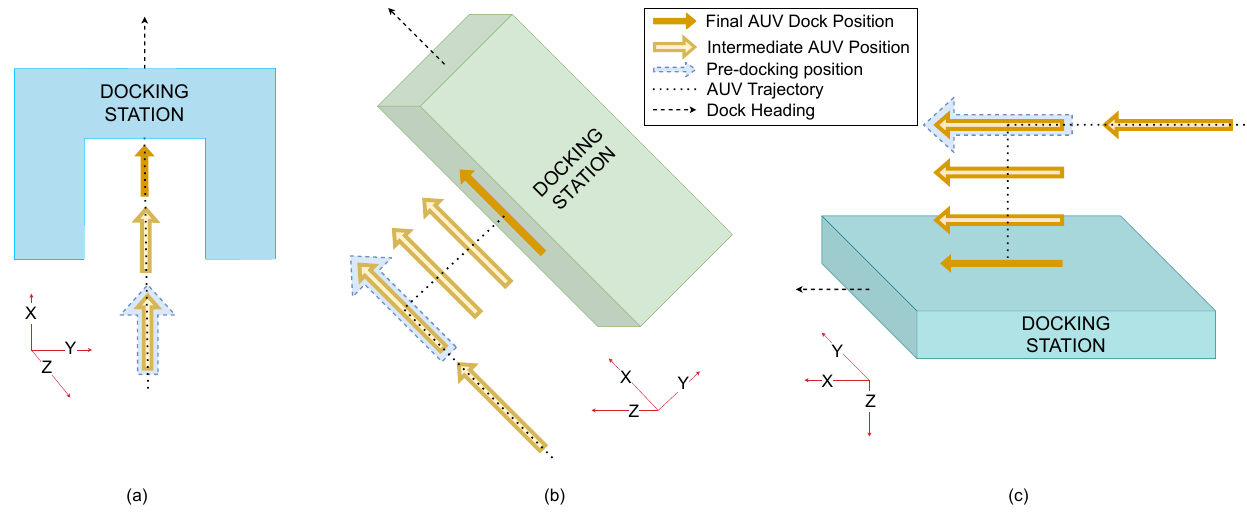
Figure 5. Docking approach from various sides of the docking station: ( a ) docking from the back (e.g., to dock on a stationary seafloor docking station), ( b ) docking from one side (e.g., to dock to the side of a surface vessel), and ( c ) docking from the top (e.g., to dock on a towed underwater docking